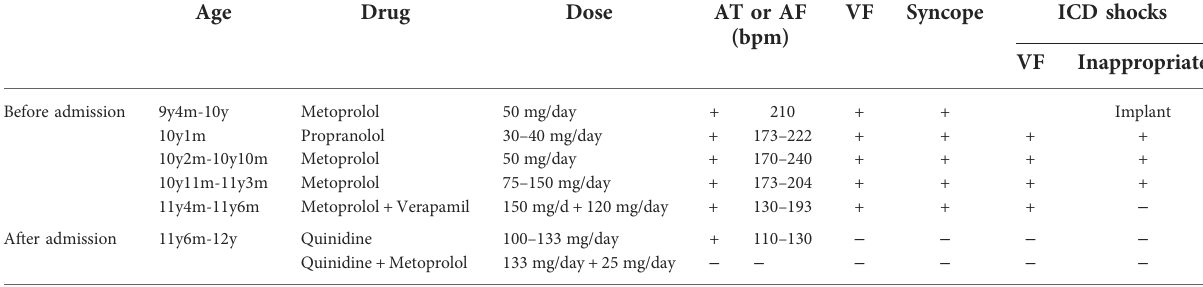
TABLE 1 Summary of antiarrhythmic drug therapy and evaluation of therapeutic effect. Age Drug